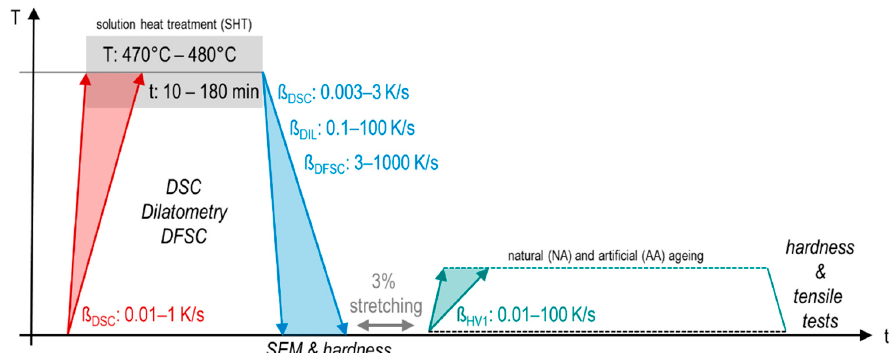
Figure 3. Schematic temperature-time profile.